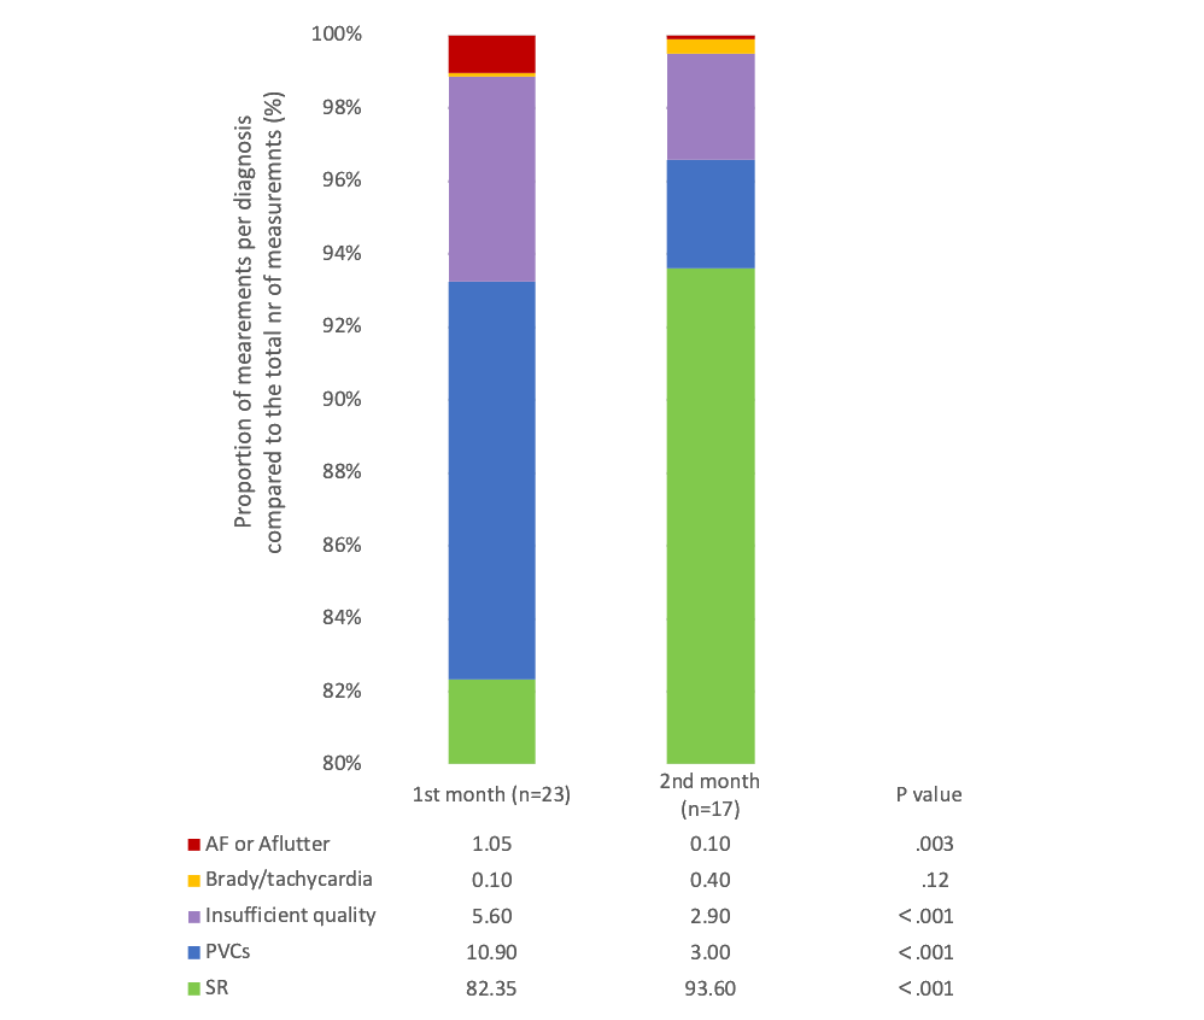
Figure 2. Overview of FibriCheck results comparing the proportion of each rhythm diagnosis between the first and second month of follow-up,